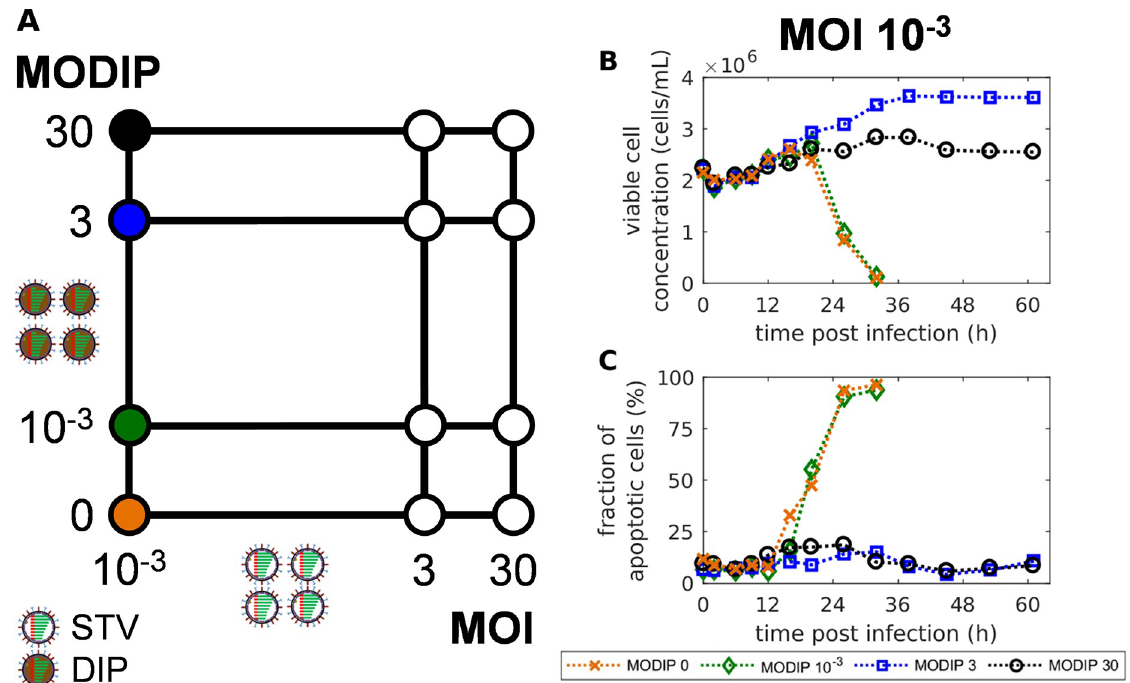
Fig 1. Addition of defective interfering particles (DIPs) can prevent virus-induced apoptosis and protect MDCKsus cells from standard virus (STV) infection. (A) Schematic depiction of the 12 different MOI and MODIP conditions used for infection experiments. (B) Viable cell concentration and (C) the fraction of apoptotic cells for infections with MOI 10 − 3 and MODIPs of 0, 10 − 3 , 3 and 30. Results for all infection conditions are shown in S1